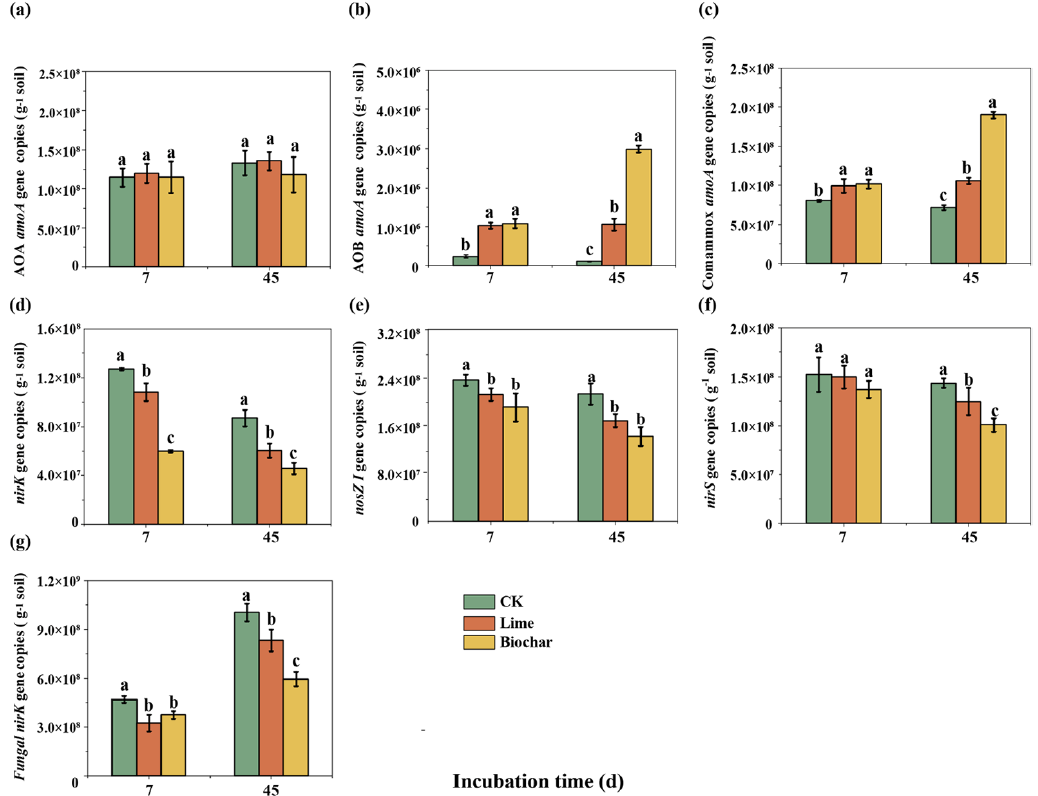
Figure 3. The copy numbers of AOA ( a ), AOB ( b ), comammox amoA ( c ), bacterial nirS ( d ), nirK ( e ), nosZI ( f ) and fungal nirK ( g ) genes copies on days 7 and 45 under di ff erent treatments. Error bars indicate standard deviations ( n = 3). Means followed by di ff erent le tt ers indicate signi fi cant di ff er- ences between treatments at p < 0.05.